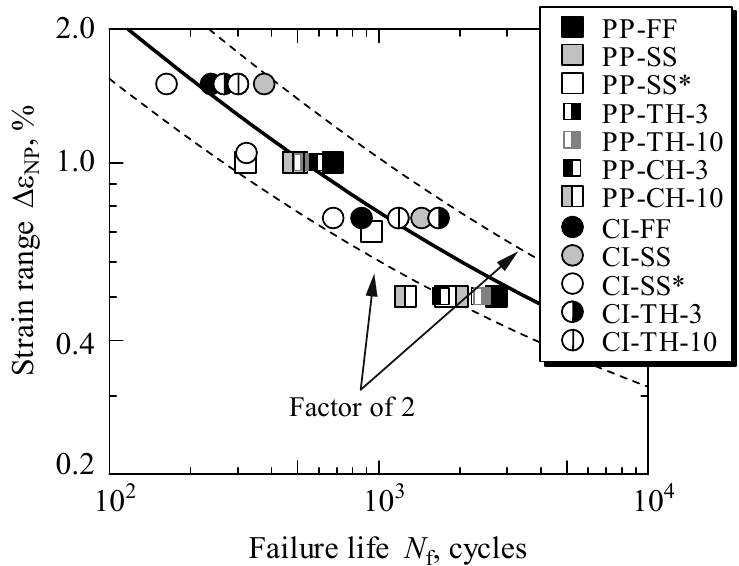
Figure 5: Correlation of N f by non-proportional strain